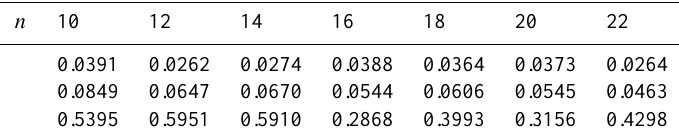
Table 11. Average divergence and the relative error for log-normal